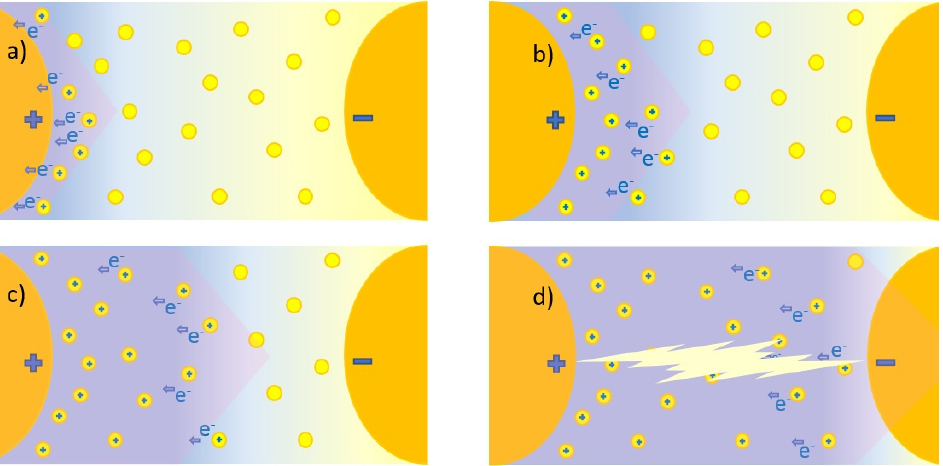
Figure 8. Streamer development and discharge in dielectric fluids: ( a ) Creation of ionized area in the positive electrode by migration of the electrons, ( b ) Increasement of the electric field in this area that promotes more ionization and migration of the electrons, ( c ) propagation of the ionization towards the negative electrode, ( d ) Completion of the ionization between the electrodes and occurrence of the discharge.